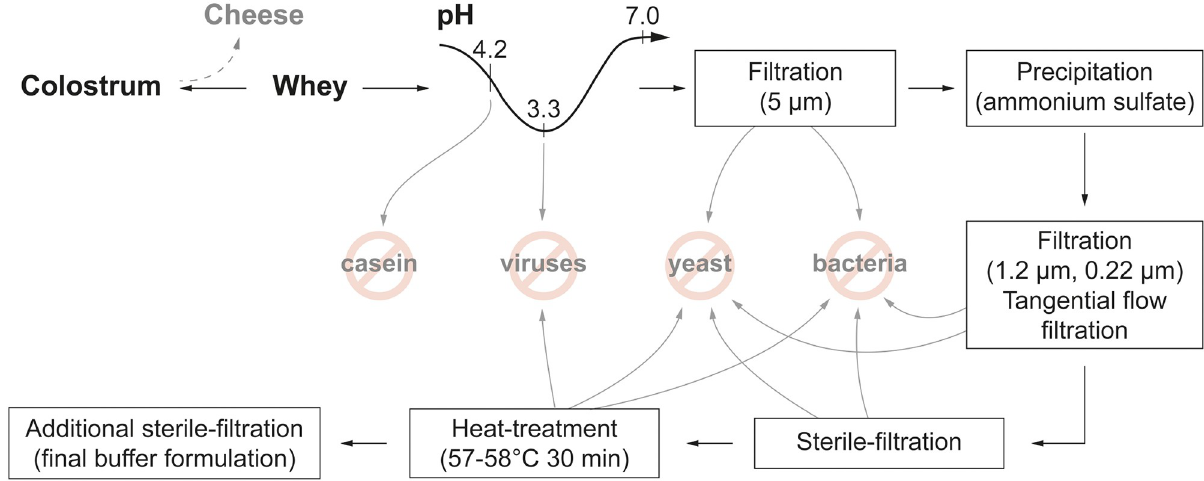
Fig 1. Schematic overview of bovine immunoglobulin preparation from